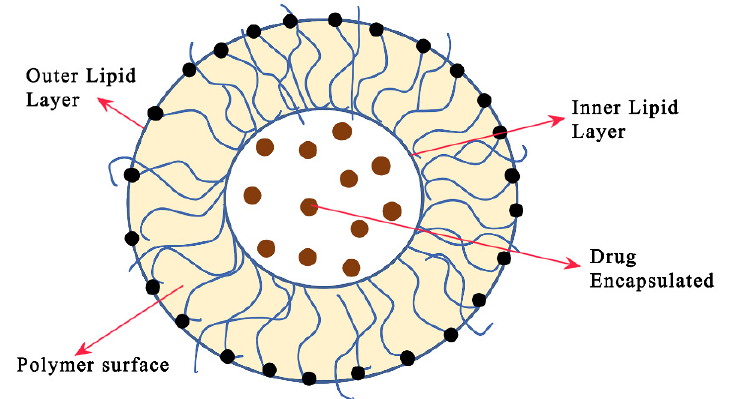
Figure 7. Illustration of a bilayer lipid-based nanocarrier with encapsulated drugs in the core; the self-assembled supramolecular architecture is shown. The solid lipid matrix encapsulates bioactive components, particularly lipophilic molecules, and releases them gradually over time. Lipid polymer nanoparticles typically have spherical particles and sizes in the range of 10 to 1000 nm. There are several forms of lipid-based nanocarriers (liposomes and niosomes) reported in reference [81] for drug delivery.